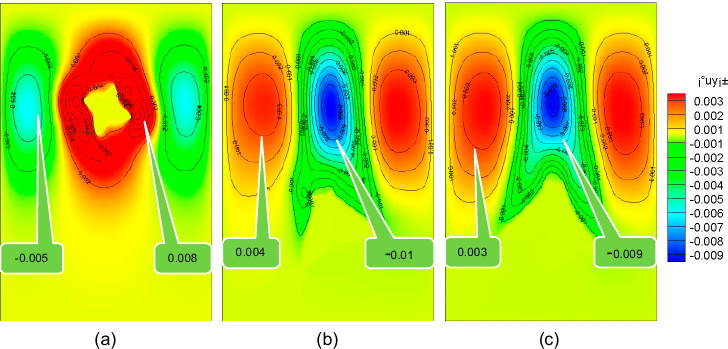
Figure 8. Flow velocity in the process of dendrite falling. ( a ) Stationary dendrites; ( b ) falling dendrites; ( c ) falling and rotating dendrites.